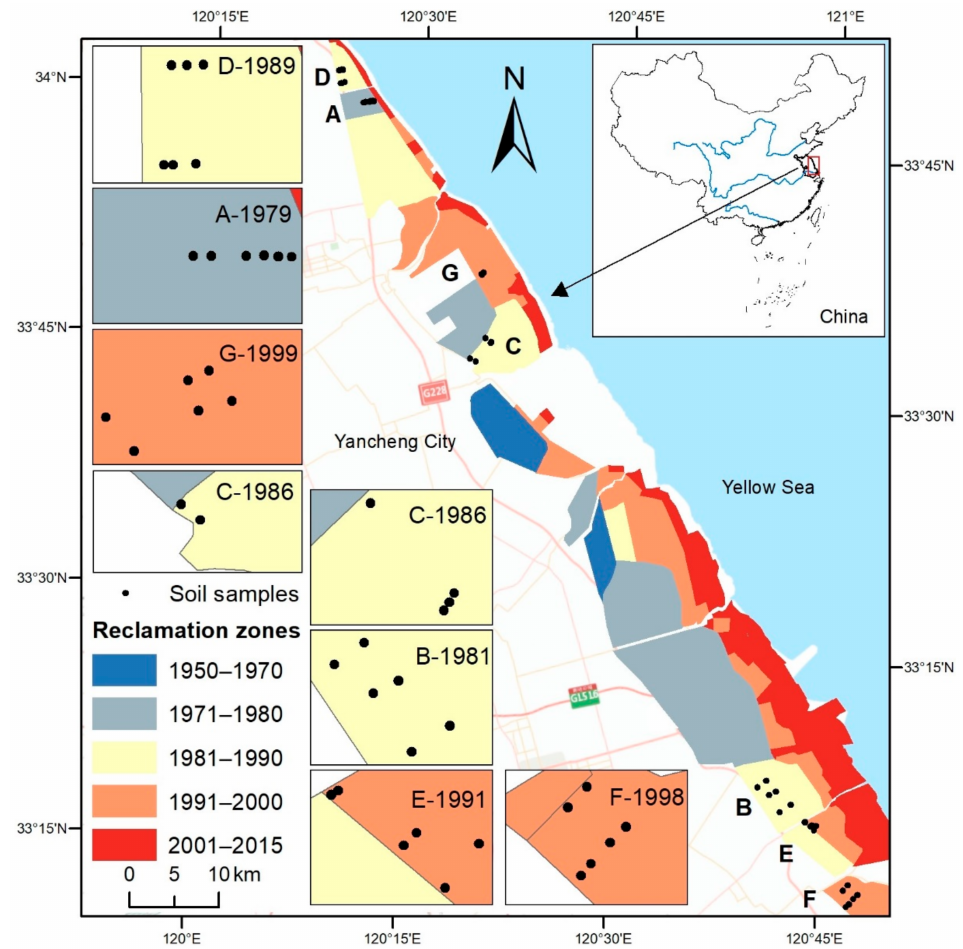
Figure 1. Location of the study area and soil sampling